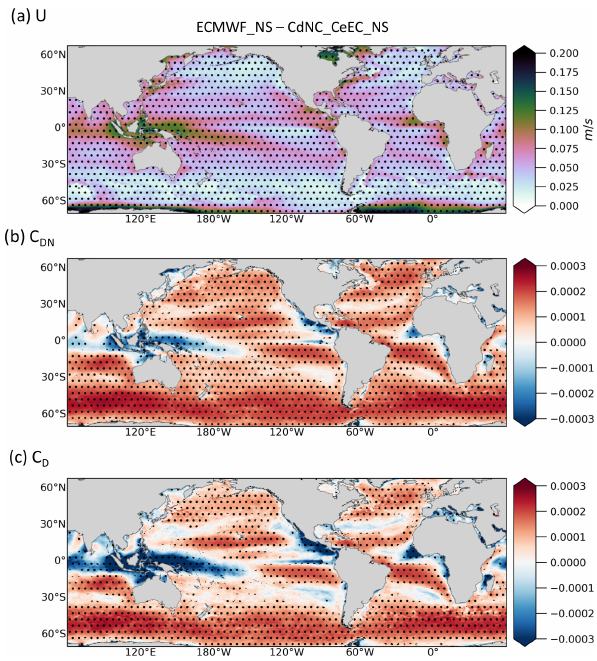
Figure 9. Annual mean differences in (a) wind speed ( U ), (b) neu- tral wind stress transfer coefficient ( C DN ), and (c) wind stress trans- fer coefficient ( C D ) between ECMWF_NS and CdNC_CeEC_NS . Hatching indicates significant values (95% confidence